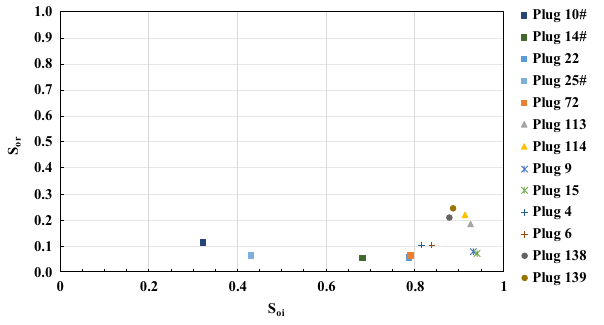
Fig. 10 Initial oil saturation ( S results for steady-state imbibition experiments